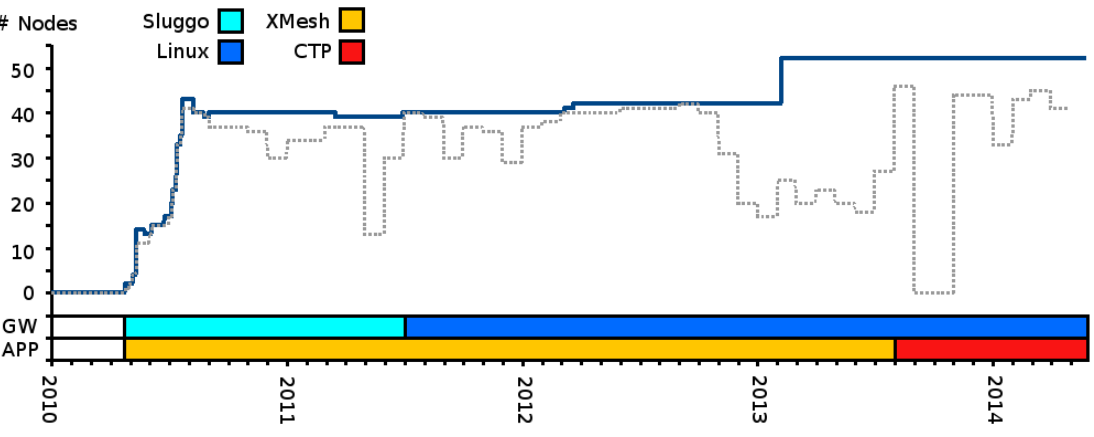
Figure 4. Timeline of the ASWP testbed deployment. In the top panel, the solid line shows the number of nodes deployed in the network from April 2010 (phase 1) to April 2014, while the dotted line represents the monthly maximum number of connected nodes within the network. At the bottom, the two bars highlight the time periods of the two network gateways (GW) and the two WSN routing protocols employed by the WSN application